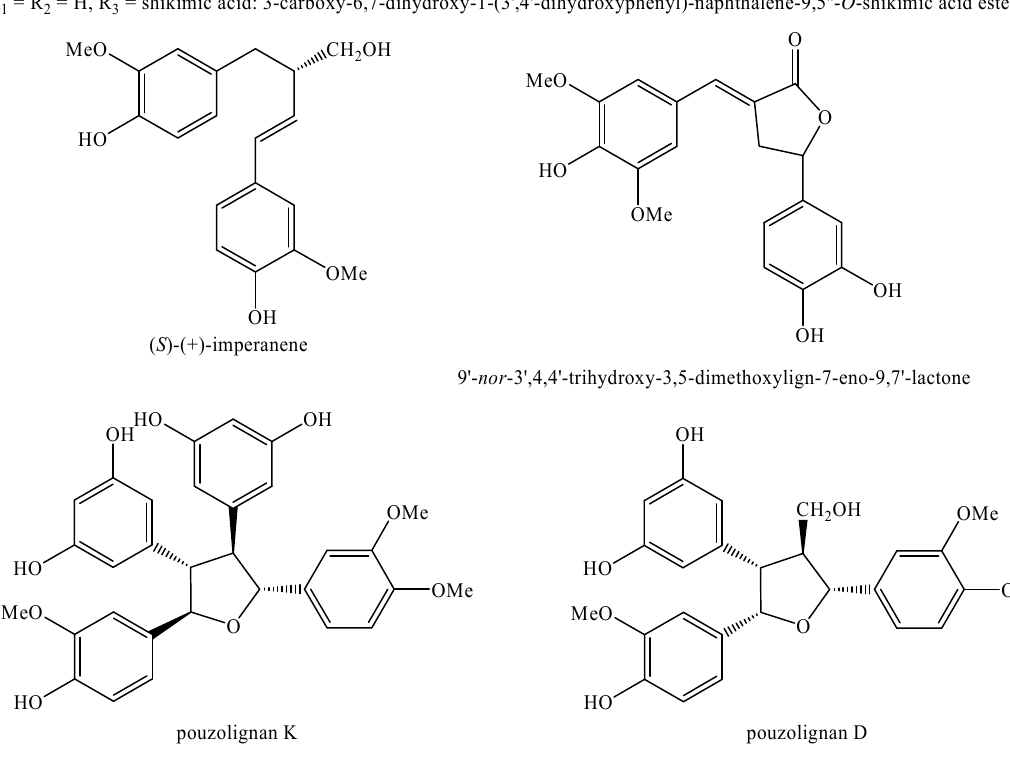
Figure 18. Isolated nor -lignans in the plant kingdom—part 17.